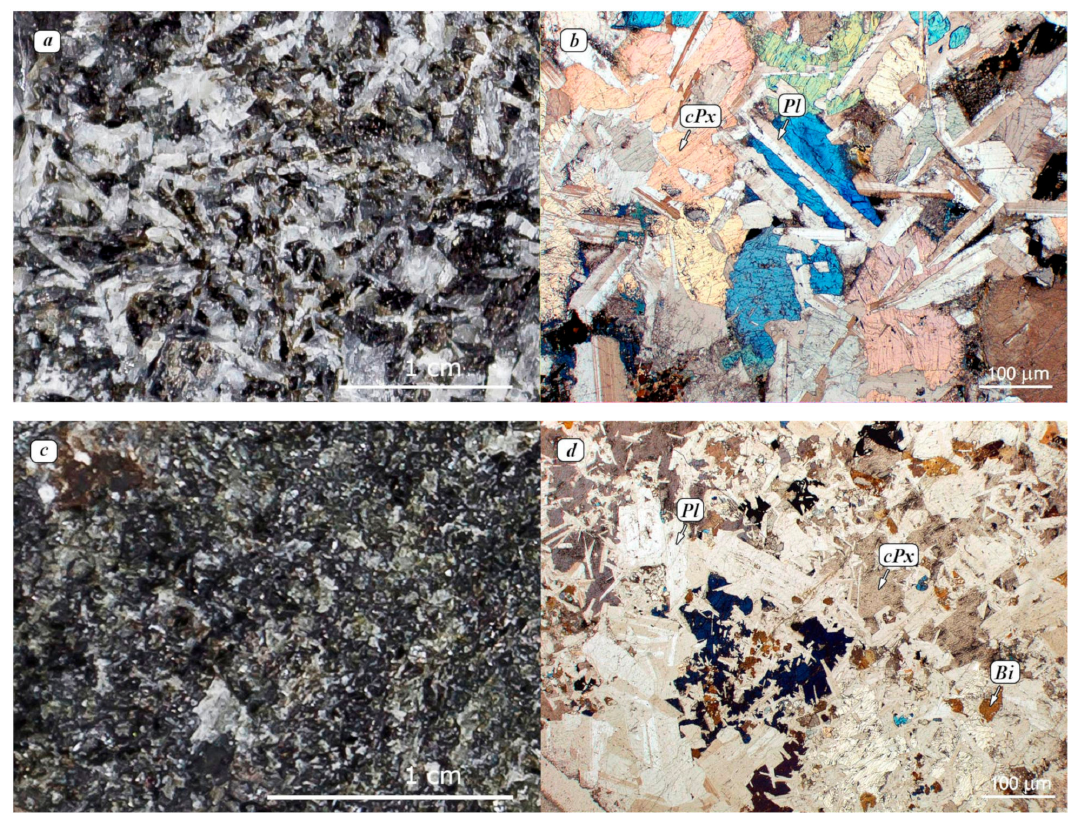
Figure 12. Photo and photomicrographs of gabbro-dolerites, samples BT-8 / 121.9 ( a,b ) and BT-8 / 219.1 ( c,d ).